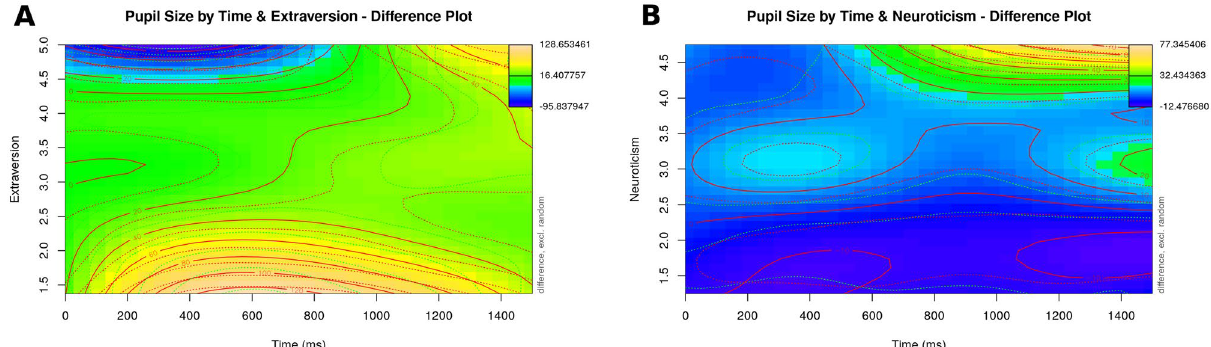
Figure 6. Visualization of the effects of item rating and the listener’s Extraversion (Panel A) and Neuroticism (Panel B) on pupil size over time in response to socio-cultural violations. Plots were generated using the itsadug (Version 2.3 63 ) package in R.